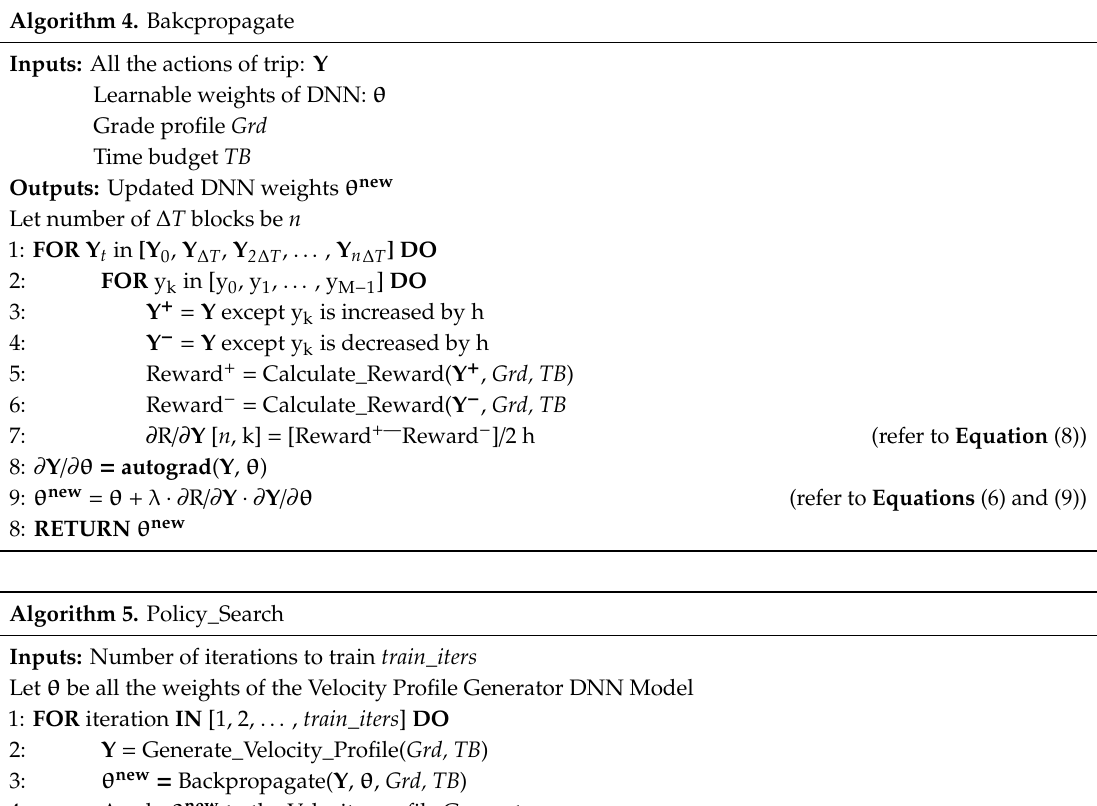
Algorithm 4. Bakcpropagate